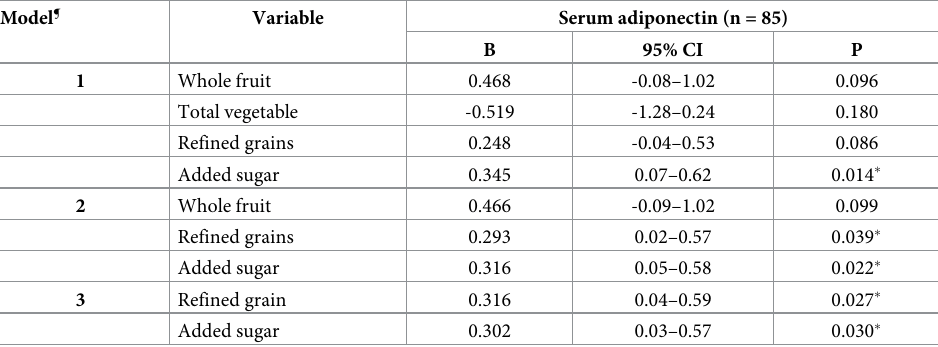
Table 4. Multiple linear regression analysis between the component score of Healthy Eating Index 2015 and serum adiponectin (n =